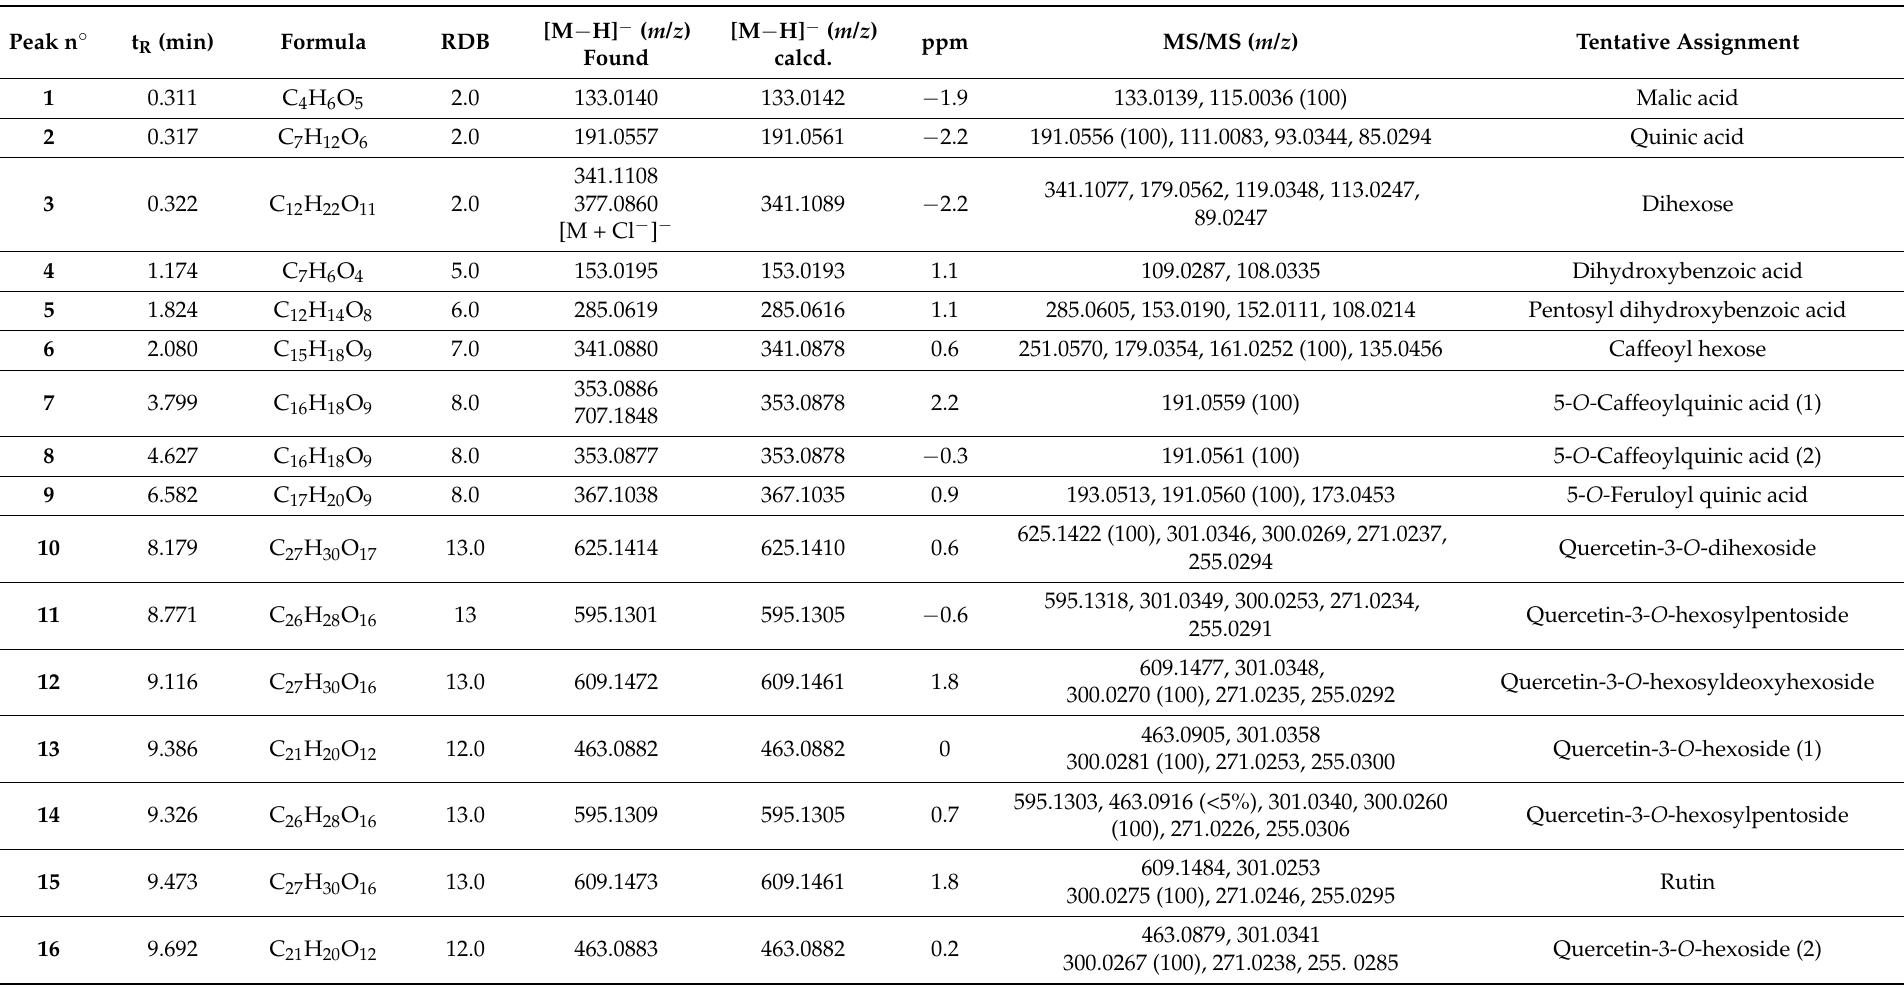
Table 1. Metabolites tentatively identified in the alcoholic extracts from the different organs of Calendula arvensis . RT, Retention Time; RDB, Ring Double Bond equivalent